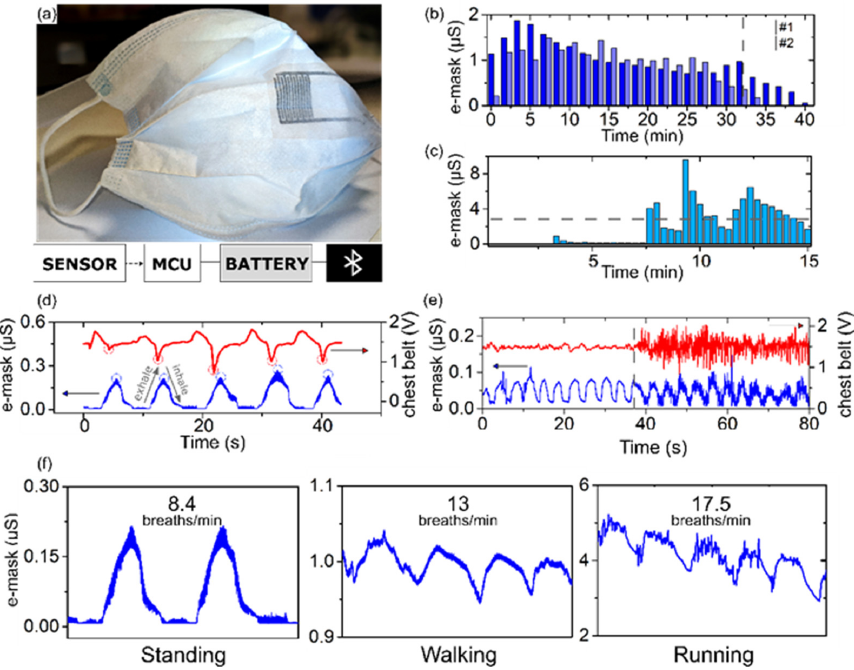
Figure 3. E-mask system response: ( a ) Picture of the final e-mask with printed IDEs (dark lines). On the bottom, a schematic presentation of the portable acquisition system for the data collection, the digitalization, and the wireless signal transfer. ( b ) E-mask time response of the wetting process monitoring during a walking activity (data from 2 different masks). The dashed line indicates when the e-mask is removed and left to dry at ambient conditions. ( c ) E-mask time response of the wetting process monitoring during running activity. The dashed line reports the 3 µ S threshold associated with the facemask damp condition. ( d ) Time window of the respiration rate monitoring: the e-mask (blue) and chest belt (red). Small circles indicate respiration cycles. ( e ) Raw signals of the e-mask (blue) and chest belt (red). The vertical dashed line indicates the passage from resting to running. ( f ) Estimation of the respiration rate from the e-mask raw signal at standing, walking, and running activities. RR estimation is given over a time window of 20 s and sensor’s response below and over the dampness threshold, demonstrating a possibility for multimodal detection in running